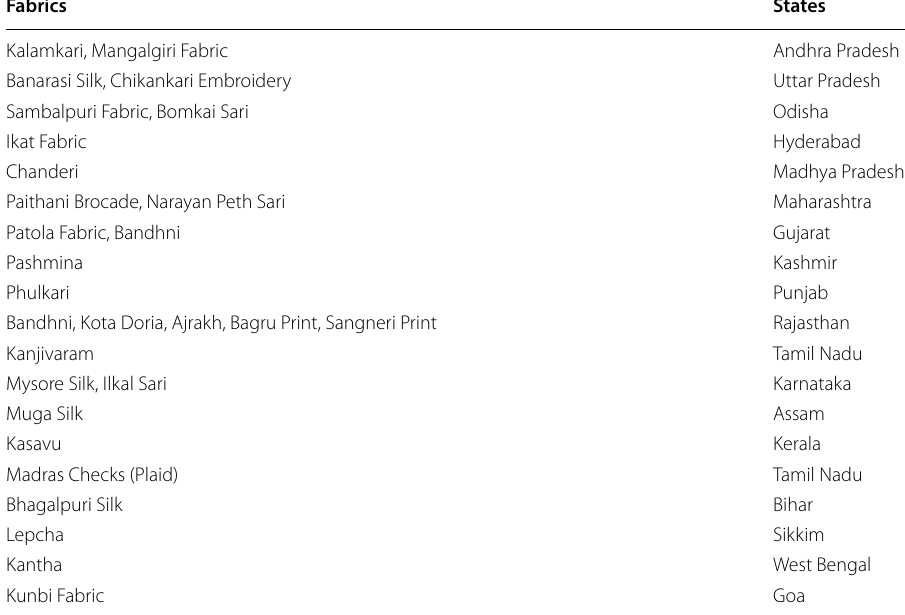
Table 1 Fabrics of India Fabrics